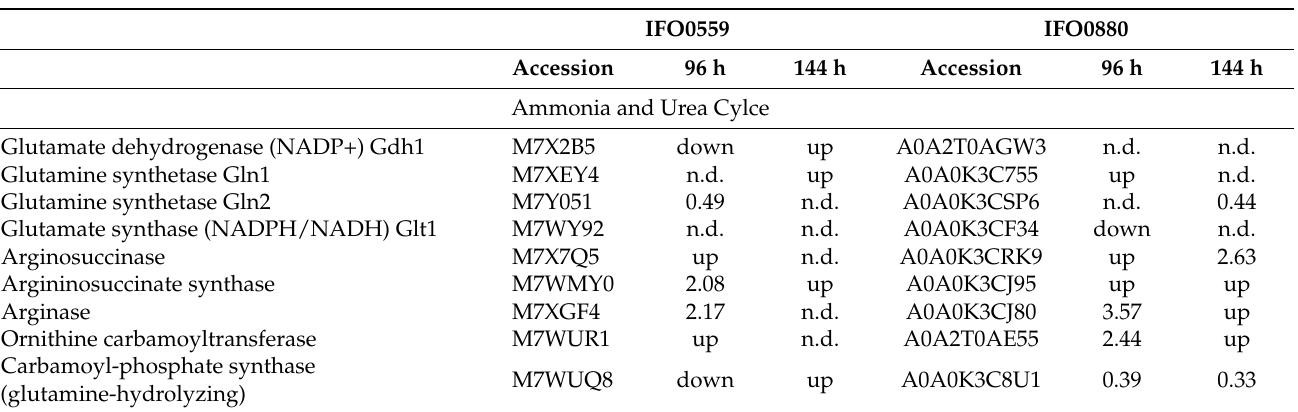
Table 6. Differentially expressed proteins involved in ammonia metabolism discussed here. For IFO0559 and IFO0880, fold change of samples grown with ammonia supplementation compared to respective control (0 mM). Protein names and UniProt accession numbers are listed. Abbreviations are written in bold. Further fold change at 96 h and 144 h of samples are stated. Fractions below 1 depict downregulation. n.d. = not detected; up = upregulated below cut-off score; down = downregulated below cut-off score. Cut-off score: significance ≤ 2 or fold change ≤